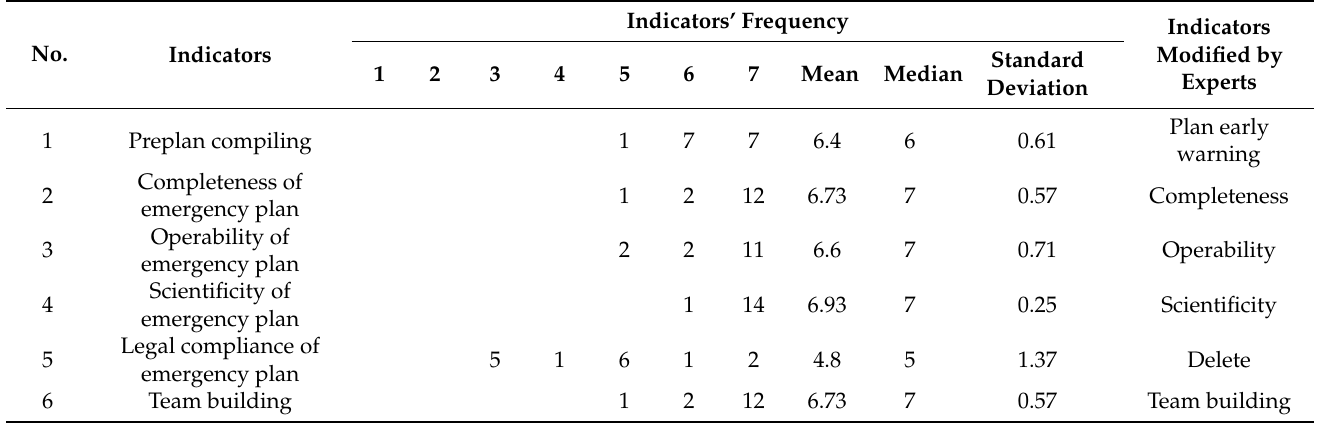
Table A3. Results of the second round of